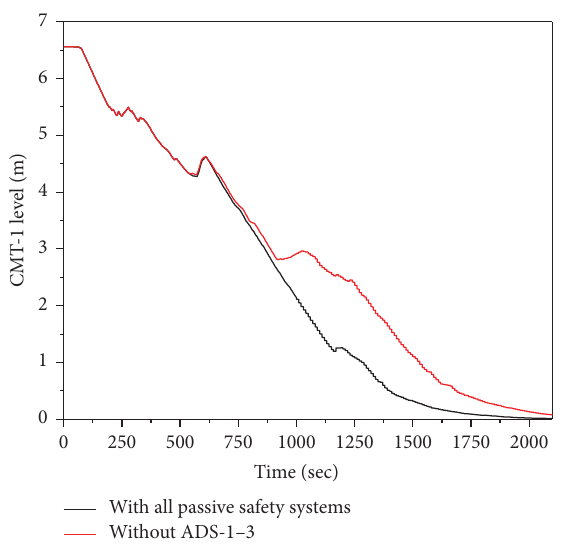
Figure 14: Comparison of CMT level in case-1 and case-3.